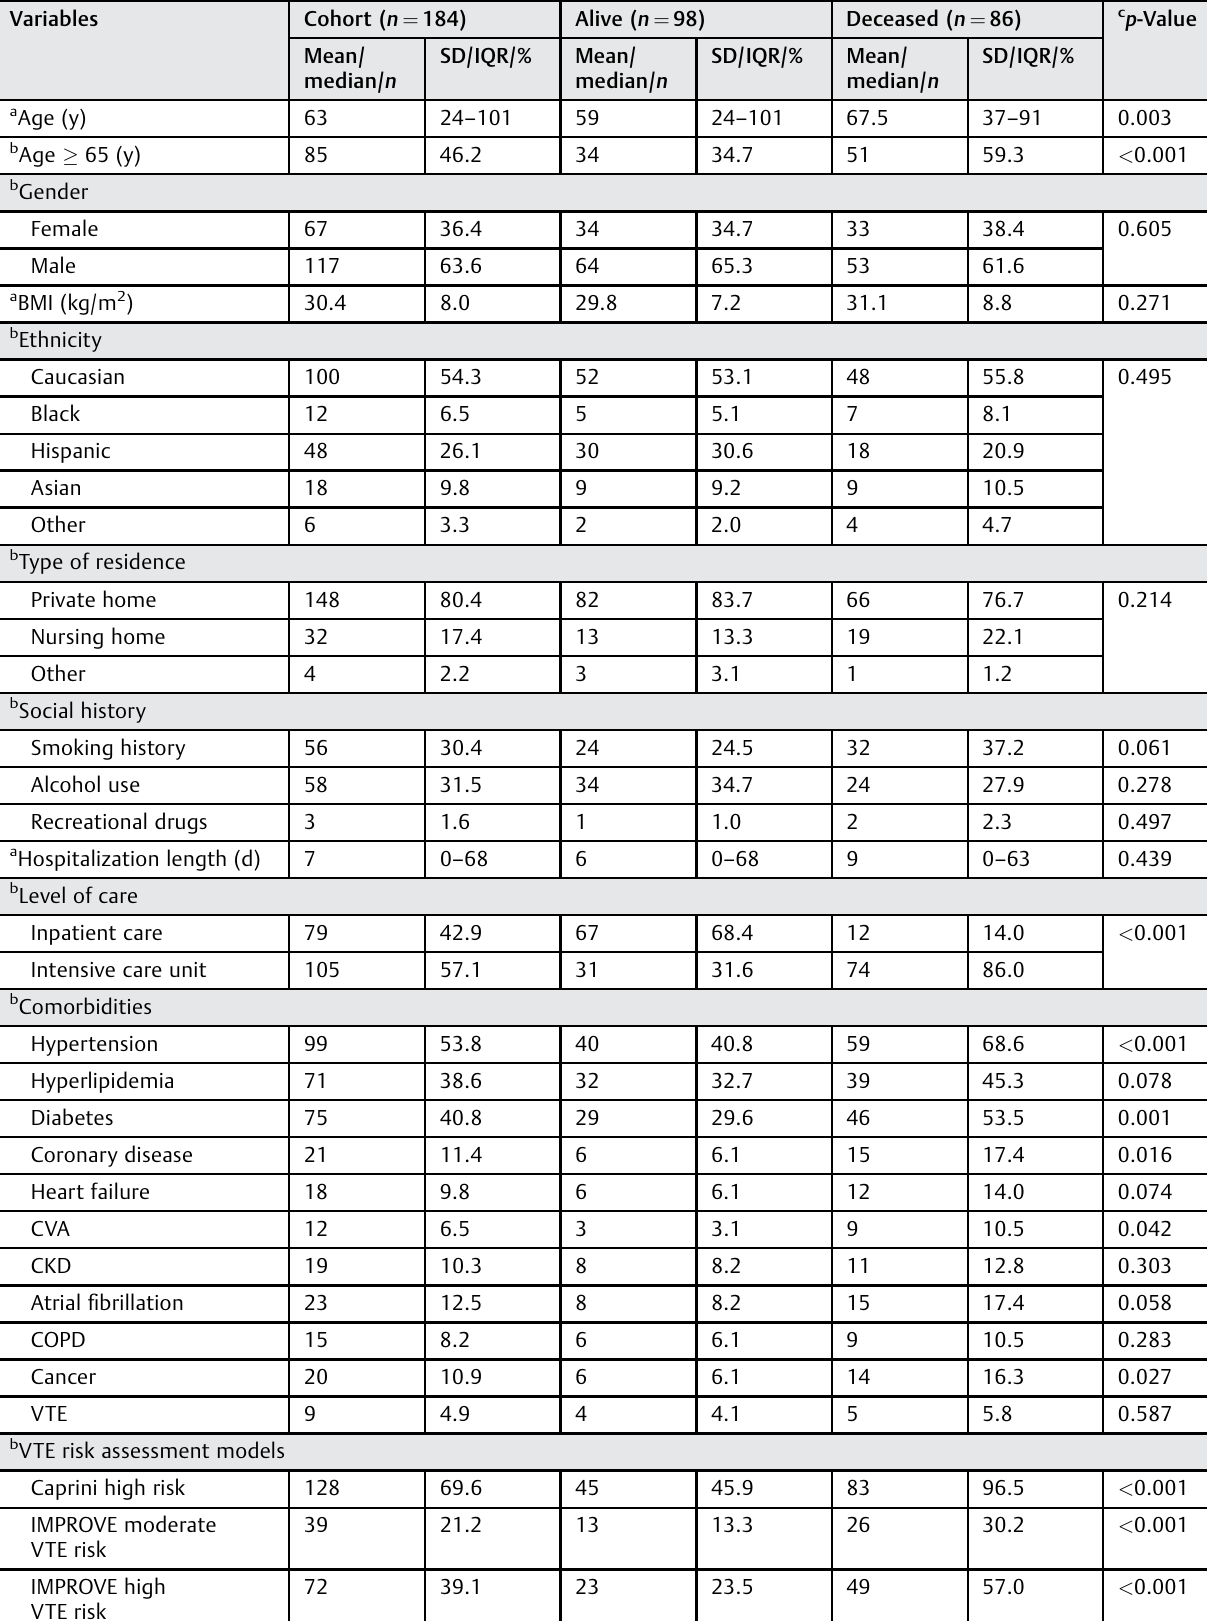
Table 1 Epidemiologic characteristics of critically ill patients with COVID-19, NorthShore University Health System